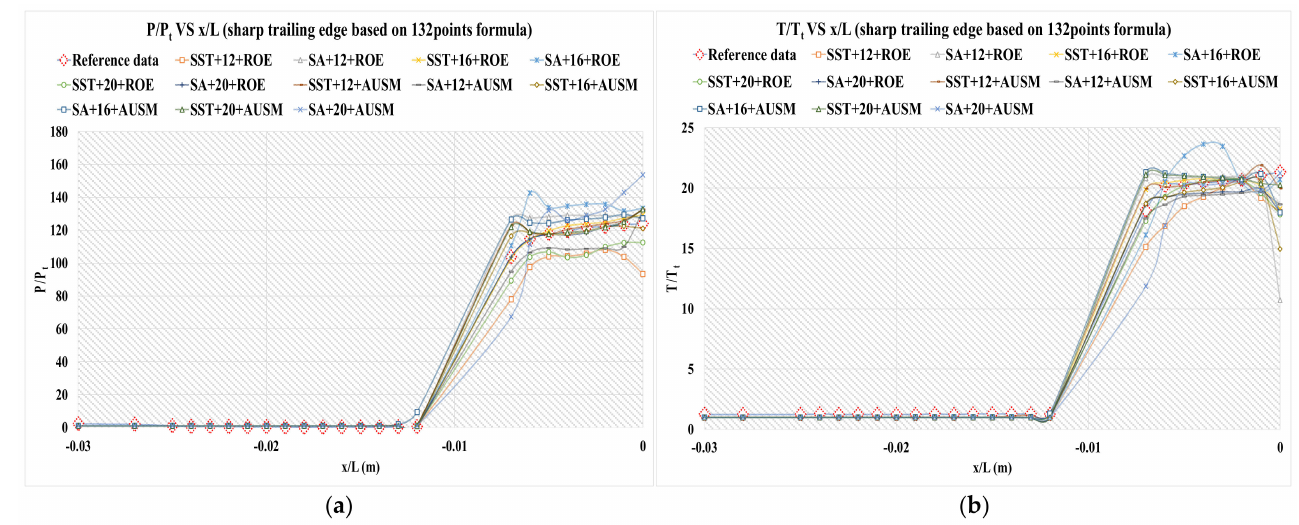
Figure 11. ( a ) Distributions of P/P t based on 132 points definition formula; ( b ) Distributions of T/T t based on 132 points definition formula.